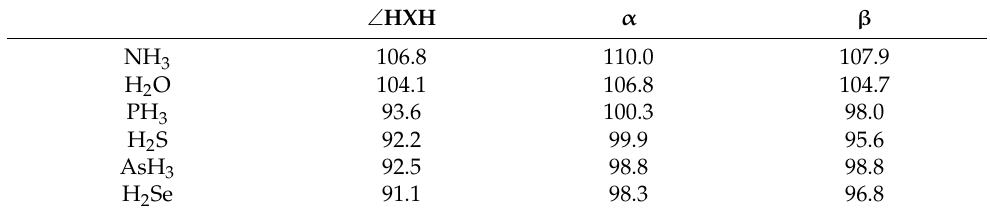
Table 2. Bond angles ( ∠ HXH) and inter-hybrid angles ( α and β ) of the Group 15 and 16 hydrides a